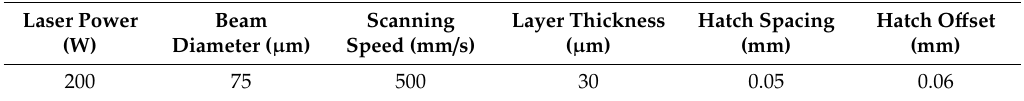
Table 2. Process parameters for the production of 316L stainless steel bulk and lattice structure specimens via SLM (Selective laser melting).